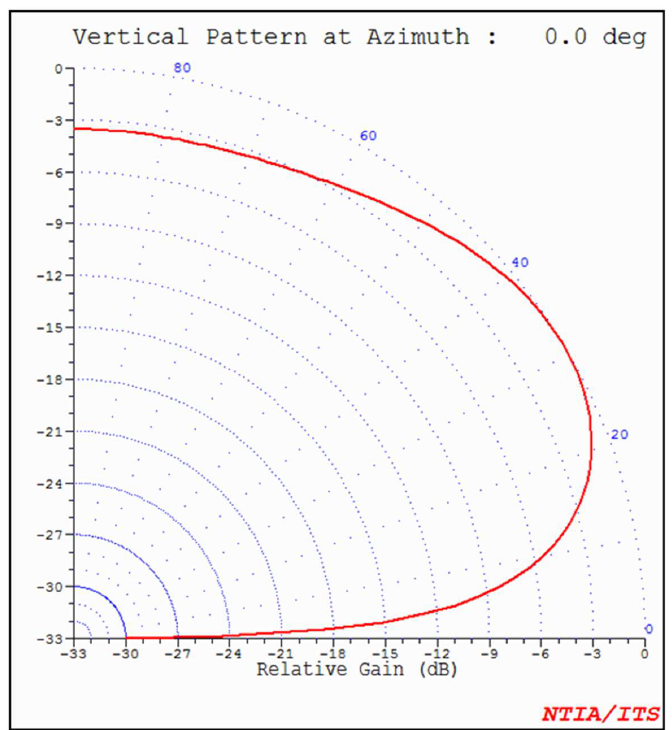
Fig. 6.a Shows HFant result ( vertical pattern) with maximum beam at 31